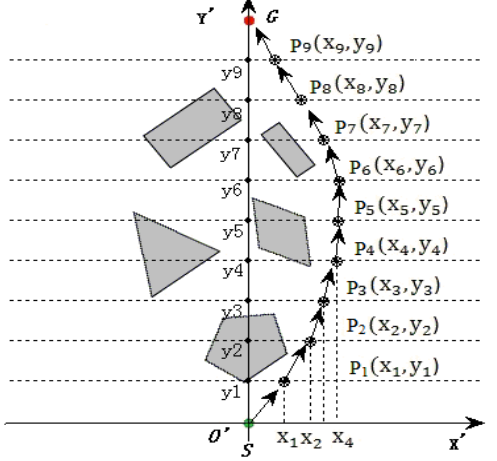
Figure 2. The new path map after coordinate transformation.